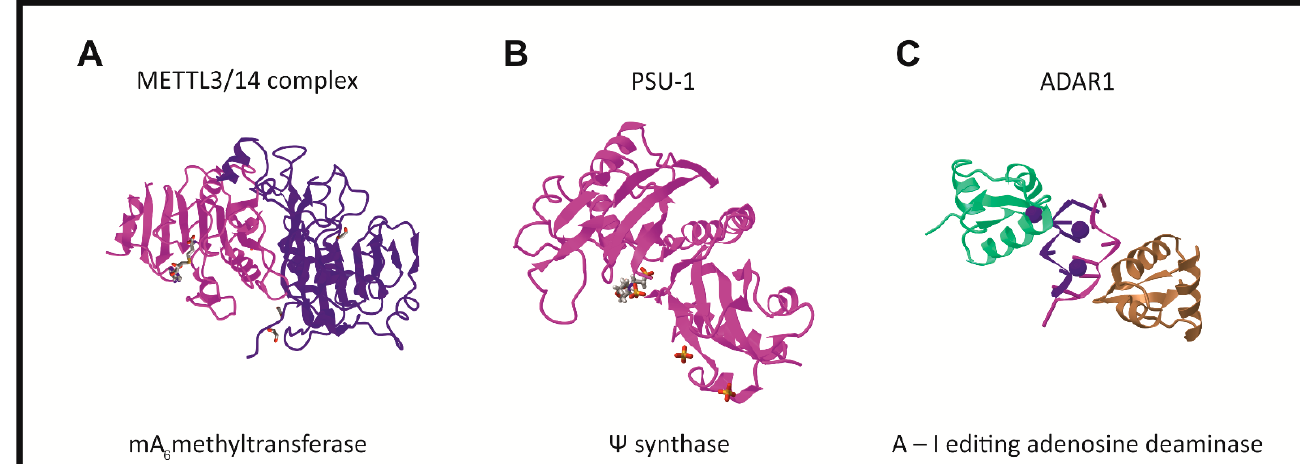
Figure 2. The crystal structure of “writer” enzymes, forming the following lncRNA modifications: ( A )—METTL3/METTL14 m 6 A methyltransferase [41]; ( B )—PSU1 pseudouridine synthase [42]; and ( C )—ADAR1 A-I editing adenosine deaminase [43].